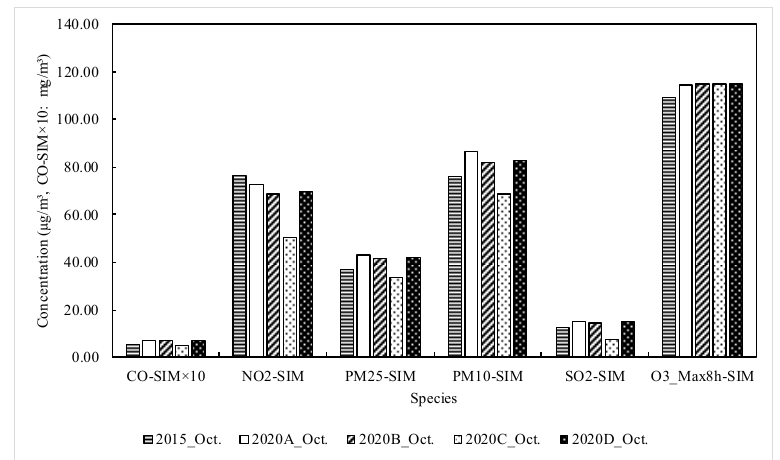
Figure 6. Comparison between simulation on October 2015 and 2020 scenarios simulation on October in Haizhu district (monthly-averaged surface concentrations).